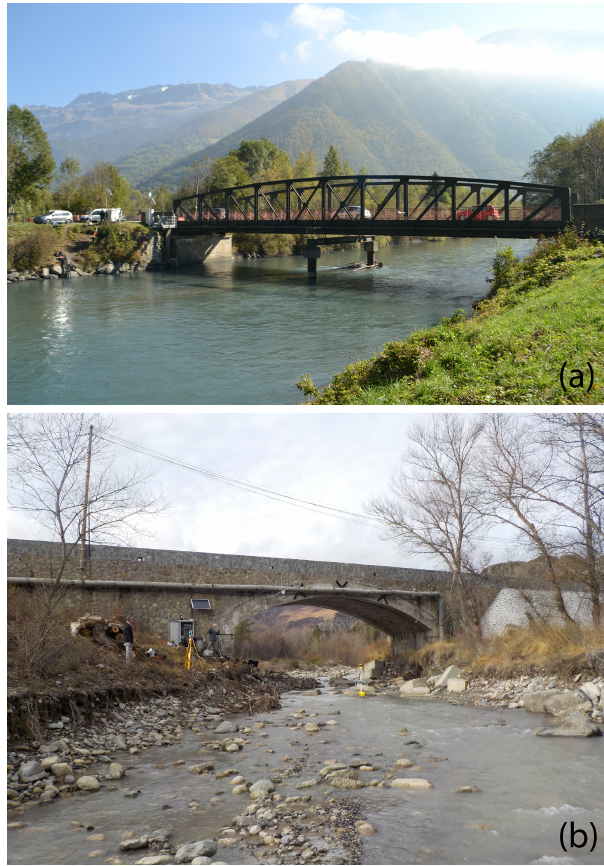
Figure 13. Overview (from downstream) of the river section where the RIPLE platform is located on (a) the Romanche in Bourg d’Oisans (45.1158 ◦ N, 6.0134 ◦ E; elevation 710m) and (b) the Gal- abre in La Robine sur Galabre (44.1586 ◦ N, 6.2360 ◦ E; elevation